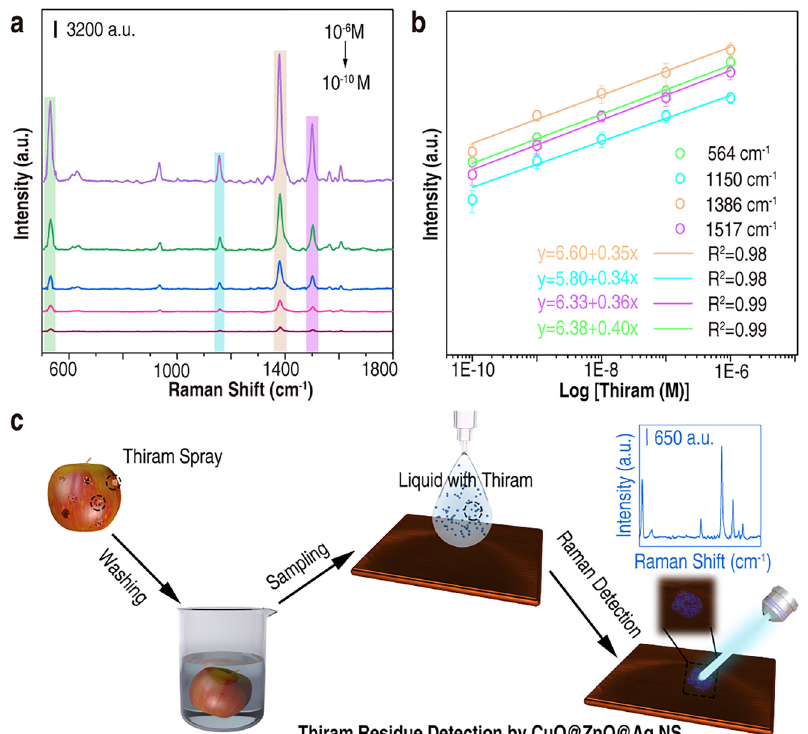
Figure 6: (a) Raman spectra of thiram (10 − 6